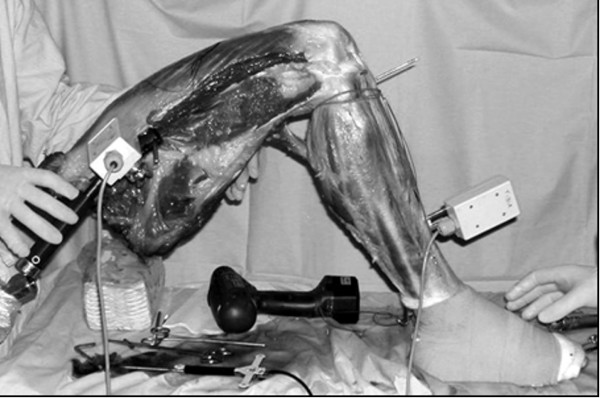
Experimental Set-up.